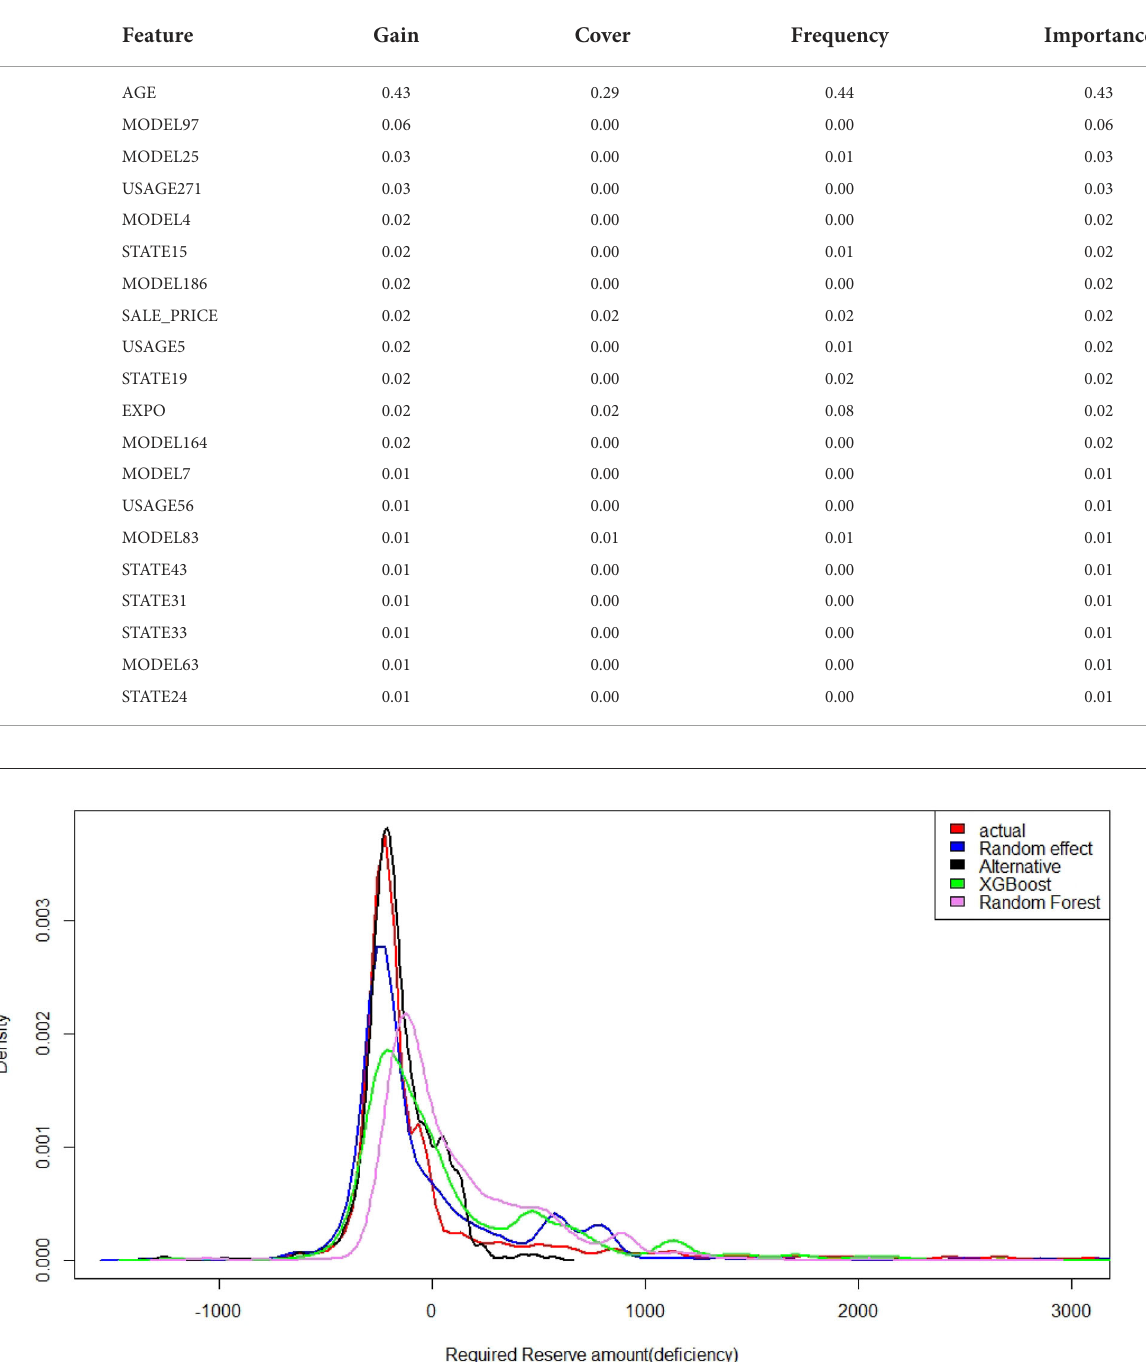
policy. Thus, the difference of $127.74 per policy if the